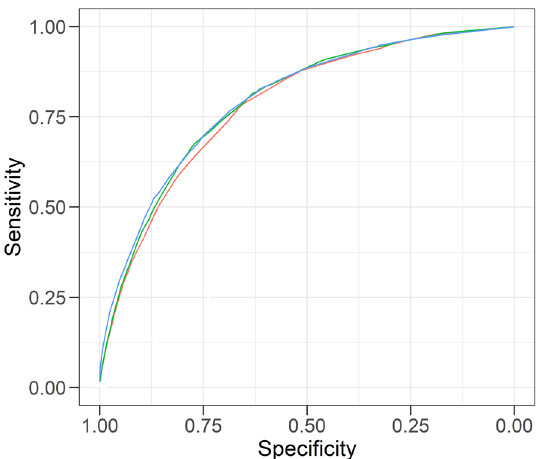
Figure 2. ROC curve of the two simple SAF-based predictive models vs. the concise FINDRISC model. Red line: Model 1, comprising age group, BMI group, SAF group (AUC 0.783, 95% CI 0.774–0.793); Green line: Model 2, comprising age group, BMI group, SAF group and number of parents with diabetes (AUC 0.792, 95% CI 0.783–0.802); Blue line: The concise FINDRISC model (AUC 0.797, 95% CI (0.787–0.806).